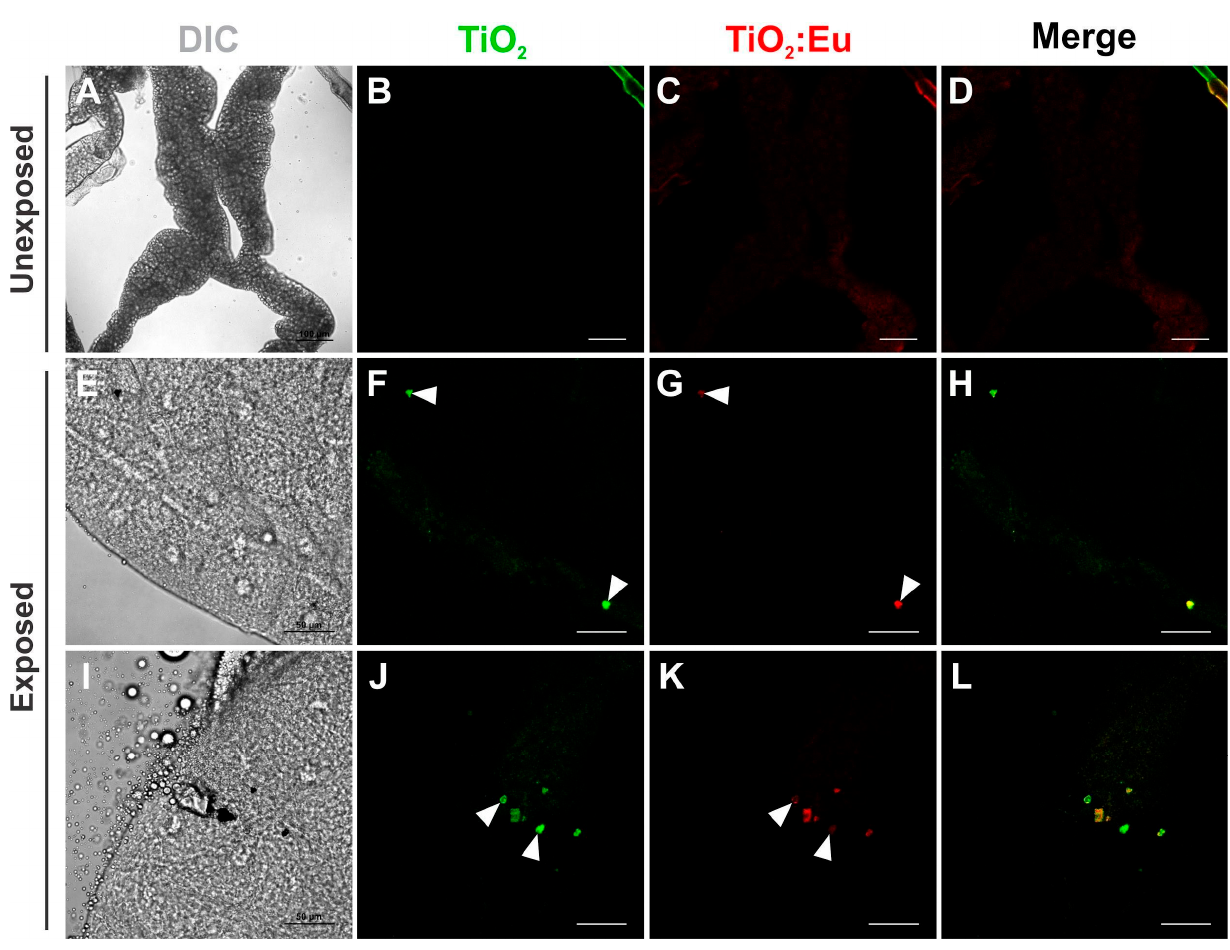
Figure 4. Confocal images of the distribution of TiO 2 and Eu 3+ -doped TiO 2 nanocrystals in the Drosophila third instar larval fat body. ( A – D ) Fat body dissected from unexposed flies fed in standard food medium show any signal of luminescence. ( E – L ) Fat body dissected from third instar larvae exposed to 4 mg/mL of TiO 2 and Eu 3+ -doped TiO 2 showed aggregates of these nanocrystals in some cells (arrowheads). DIC: differential interference contrast; Green: TiO 2 nanocrystals fluorescence under 405 nm excitation; Red: Eu 3+ -doped TiO 2 nanocrystals fluorescence under 552 nm excitation. Scale bars: 100 μ m ( A – D ); 50 μ m ( E – L ).